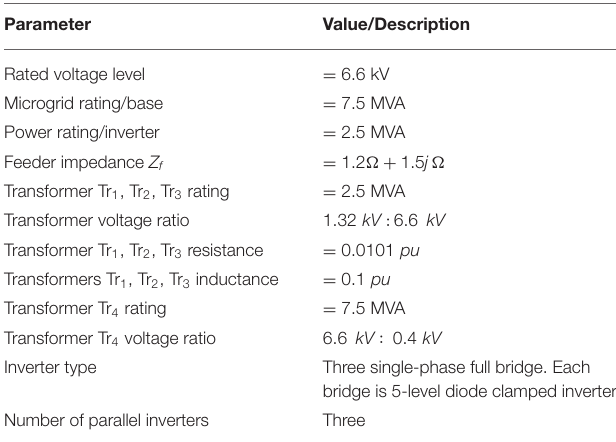
TABLE 1 | Microgrid and inverter